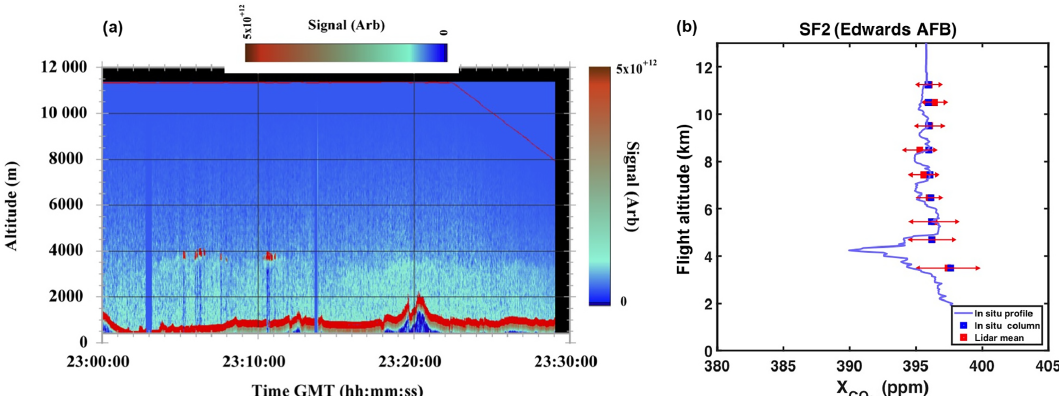
Figure 15. (a) Time history of the range-resolved backscatter for the offline wavelengths recorded on 2014 SF2 before the spiral-down maneuver. The plot shows enhanced scattering from haze in the boundary layer. The aircraft altitude is the thin red line at the top of the plot. Each vertical profile is R 2 corrected and used 1s averaging. (b) Summary of the in situ (blue) CO 2 measurements and the XCO 2 retrievals from lidar measurement (red) vs. altitude for the segment in Fig. 15. The lidar results are for XCO 2 retrievals based on 10s average from the altitude where the results are plotted to the surface, and the error bars are for 1 SD. The XCO 2 values computed from the in situ sensor from the plotted altitude to the ground are shown as the blue dots.